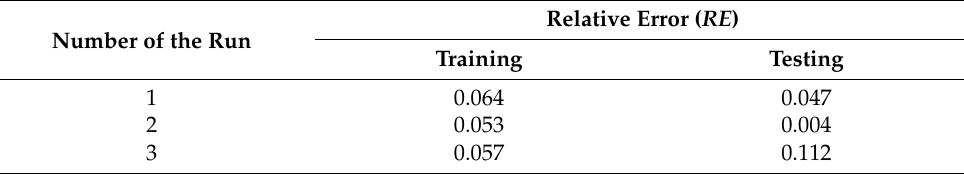
Table 7. Relative errors of the ANN model with the twenty-two data sets after three runs.